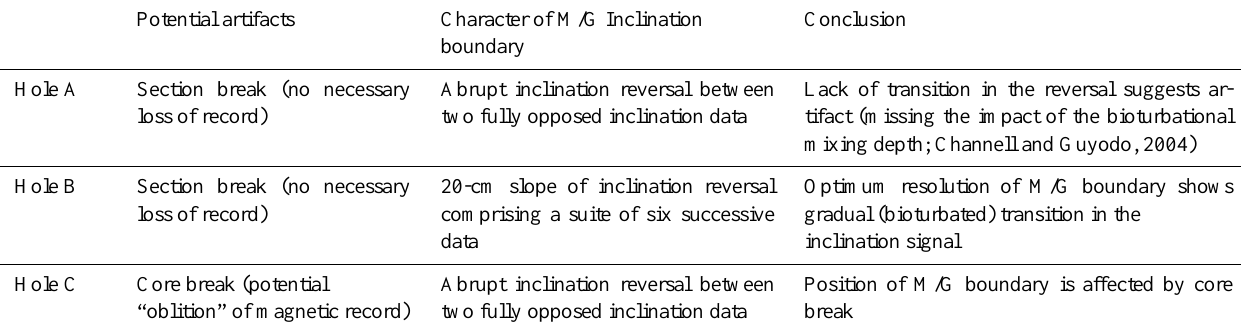
Table 1. Evaluation of uncertainties in the midpoint assignment for definition of the Matuyama/Gauss (M/G) boundary in ODP holes 982 A, B, and C (inclination data of Channell and Lehmann,